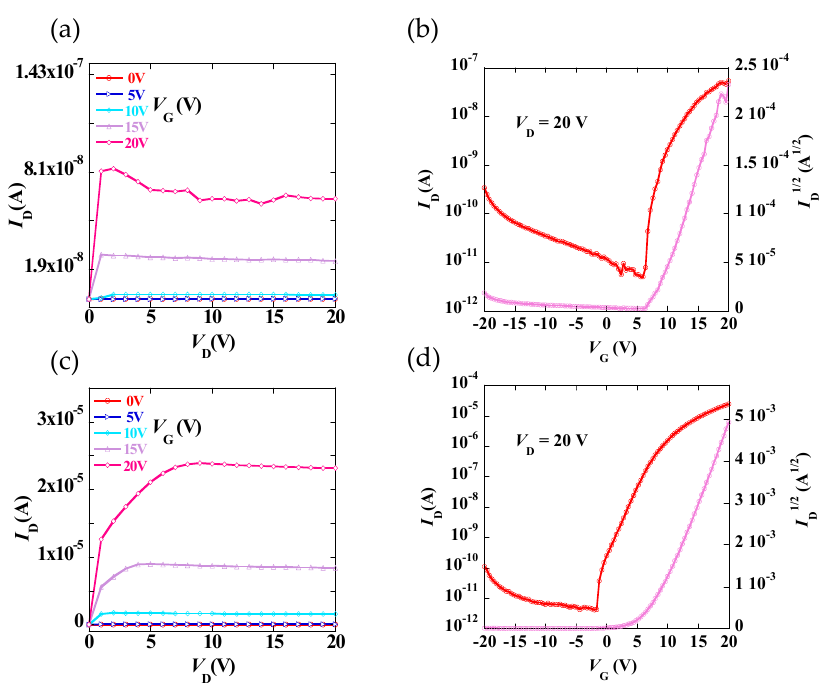
Figure 4. ( a ) Output and ( b ) transfer characteristics of the device with silver nanoparticle ink. ( c ) Output and ( d ) transfer characteristics of the device with silver salt ink.